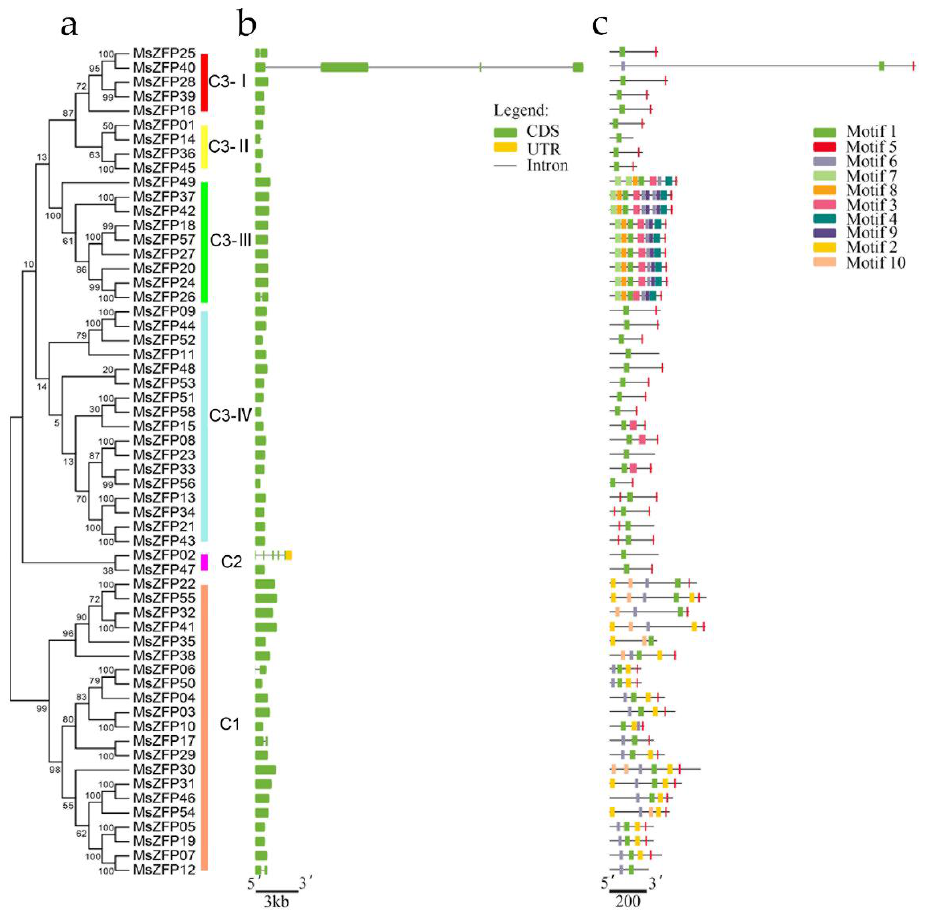
Figure 2. Phylogenetic relationship, gene structure, and motif compositions of alfalfa Q-type C2H2- ZF genes. The phylogenetic tree was constructed using MEGA 6.0 with the neighbour-joining method. ( a ) Multiple alignments of 58 protein sequences of alfalfa MsZFP s executed by ClustalW. ( b ) Exon/intron structures of alfalfa C2H2-ZFP genes. Exon/intron structures were analyzed by the Gene Structure Display Server. Exons/introns of each subgroup are represented by green boxes and black lines, respectively. ( c ) Schematic representation of the conserved motifs, as identified by MEME; each coloured box represents a motif.